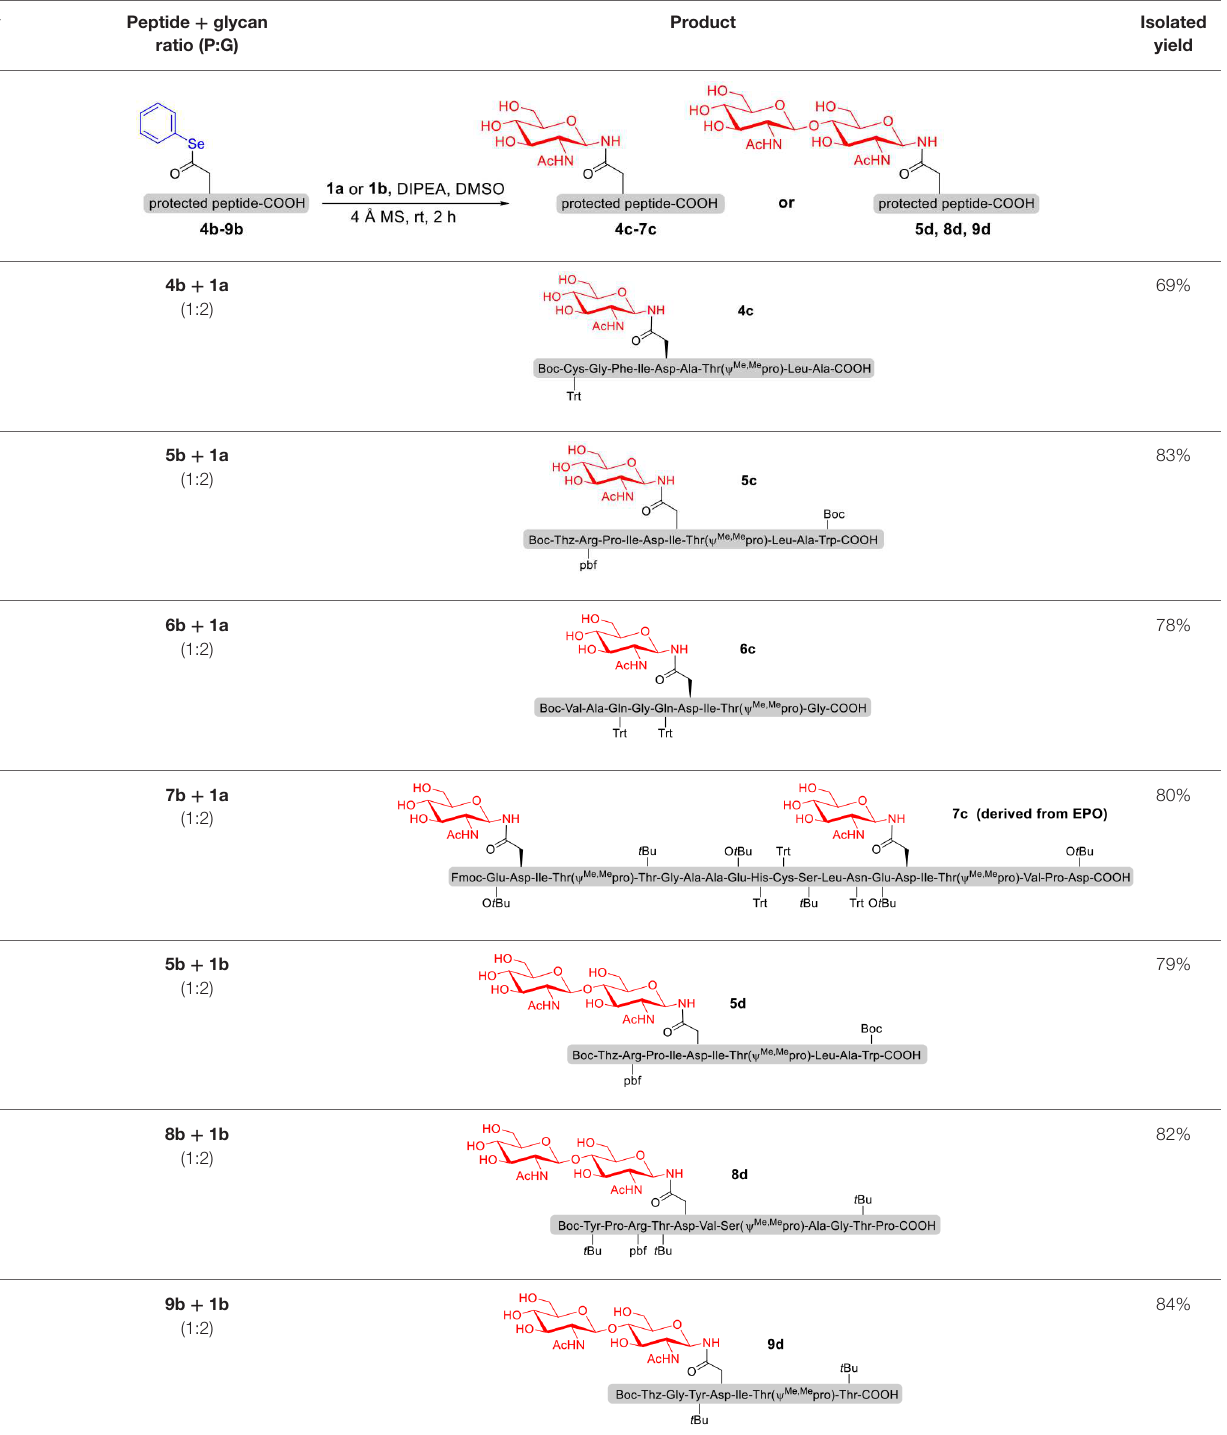
TABLE 4 | Scope of the peptidyl selenoester-based glycosylation a . Entry Peptide + glycan ratio (P:G)